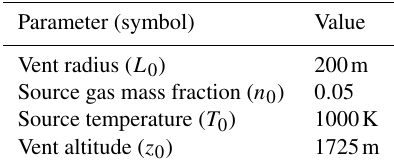
Table A1. Source parameter value used in the plume model for 0500 on 22 May 201.